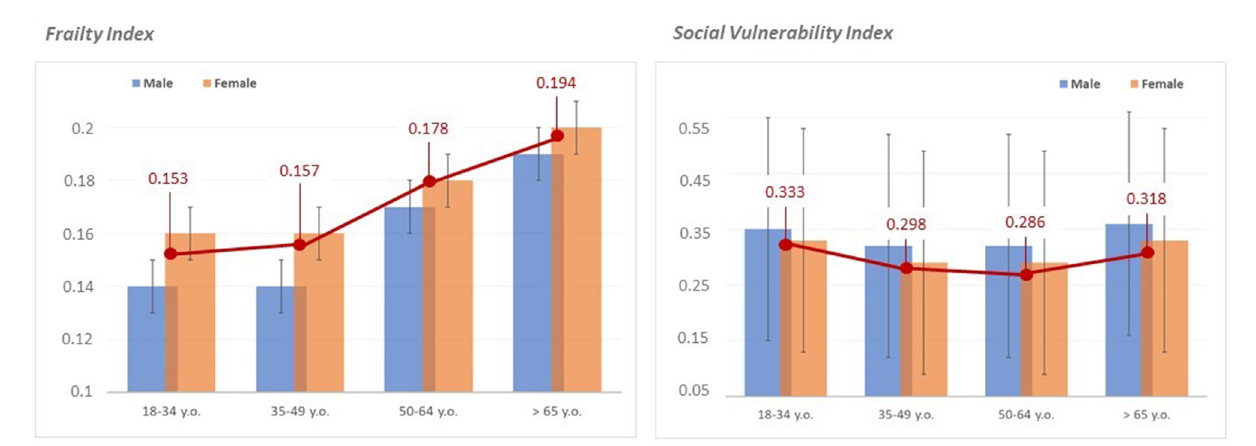
FIGURE 1 | Distribution of frailty and social vulnerability by age categories and gender. The figure illustrates the mean distribution of the frailty index (on the left) and the social vulnerability index (on the right) in the whole sample (red lines) grouped by age categories (18–34 y.o. = young adults; 35–49 y.o. = middle adults; 50–64 y.o. = old adults; > 65 y.o. = elders). Blue and orange histograms indicate distribution patterns of frailty and social vulnerability indices in males and females,